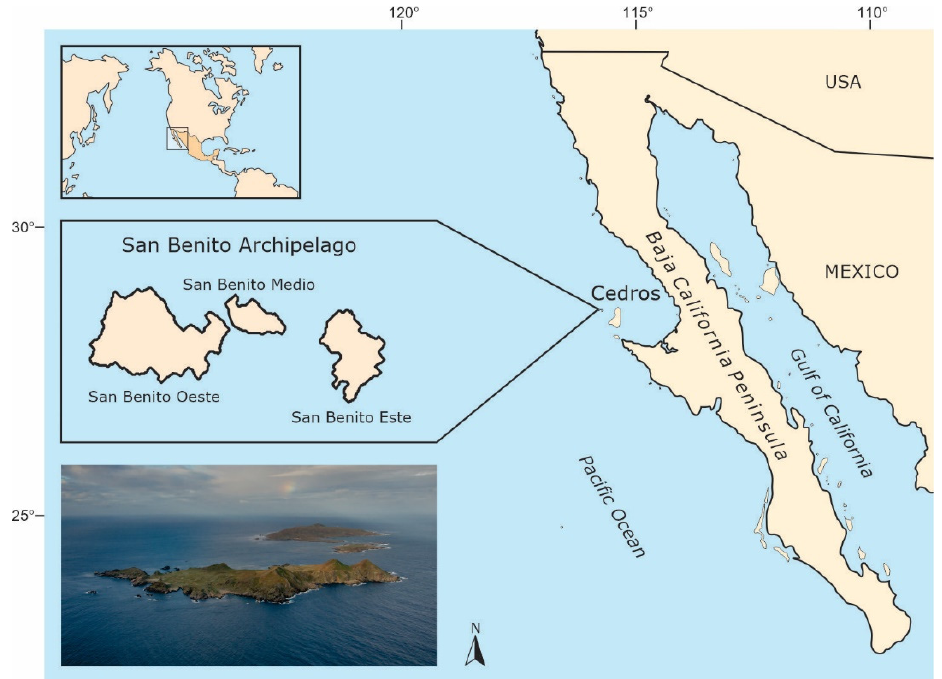
Figure 1. Location of the San Benito Archipelago in the Mexican Pacific off the Baja California Peninsula. The photo is an aerial panoramic view of the archipelago with San Benito Oeste Island in the foreground. Photo: © GECI/J.A. Soriano.